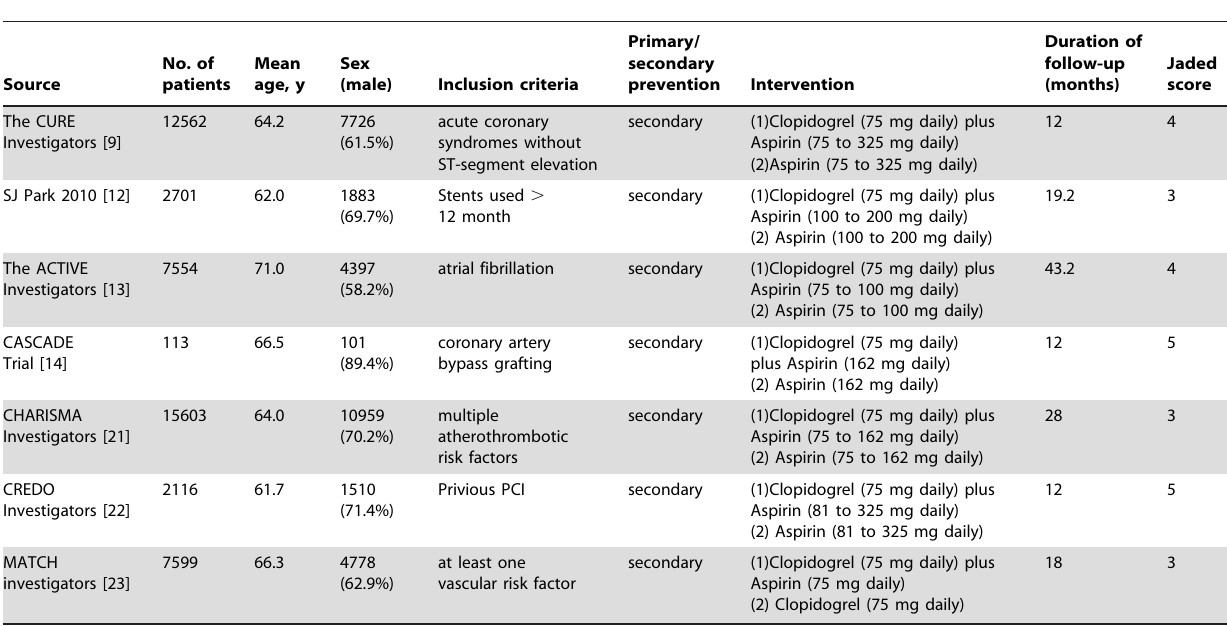
Table 1. Design and characteristic of trials included in the systematic review and meta-analysis.